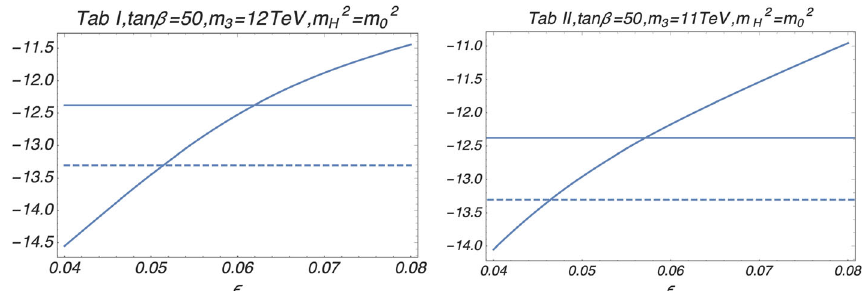
breaking sector has a structure similar to the CKM